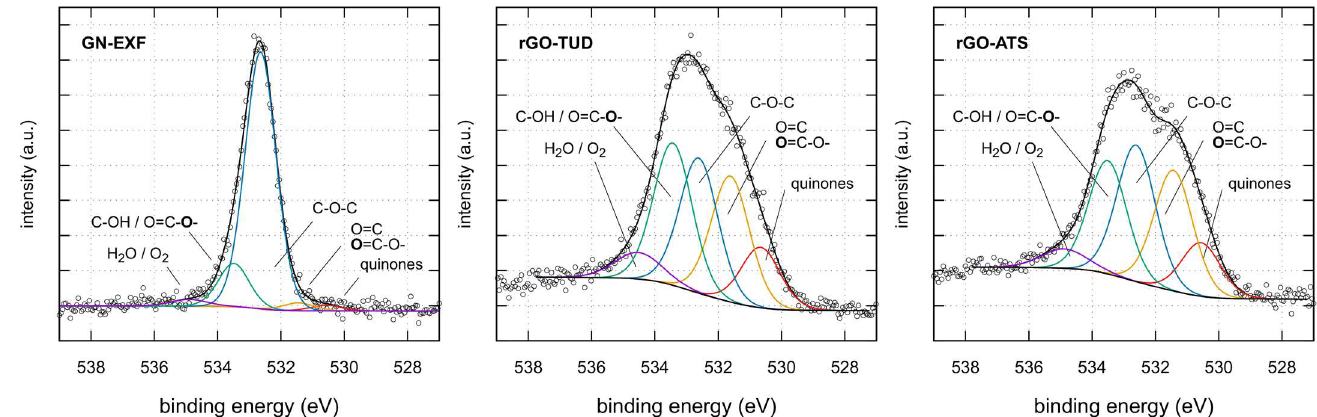
Figure A2. XPS results: O1s high resolution spectra of GN/ExF, rGO/TUD and rGO/ATS.